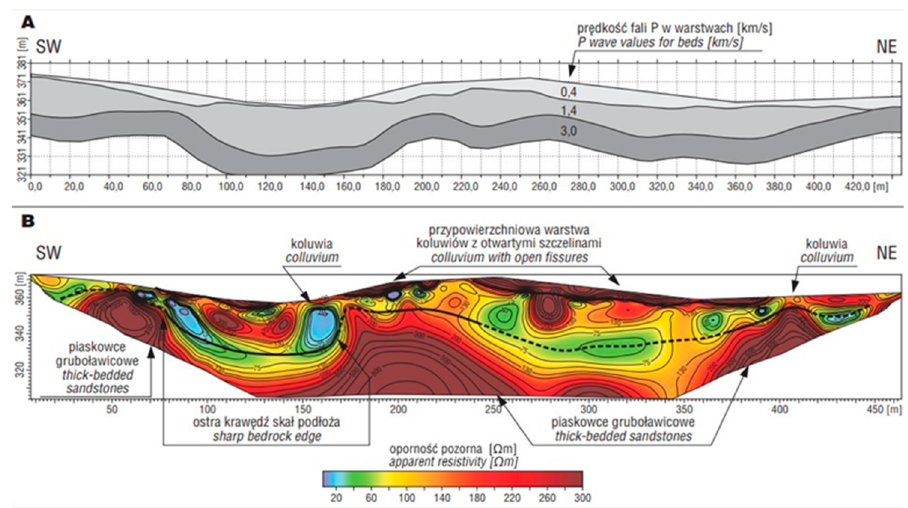
Figure 1. Transverse geophysical sections (subperpendicular to the landslide axis), Miedzybrodzie. A : Seismic section obtained by means of the seismic refraction profiling method. B : Apparent resistivity section obtained by means of the electrical resistivity tomography (ERT) method, with geological interpretation [10].